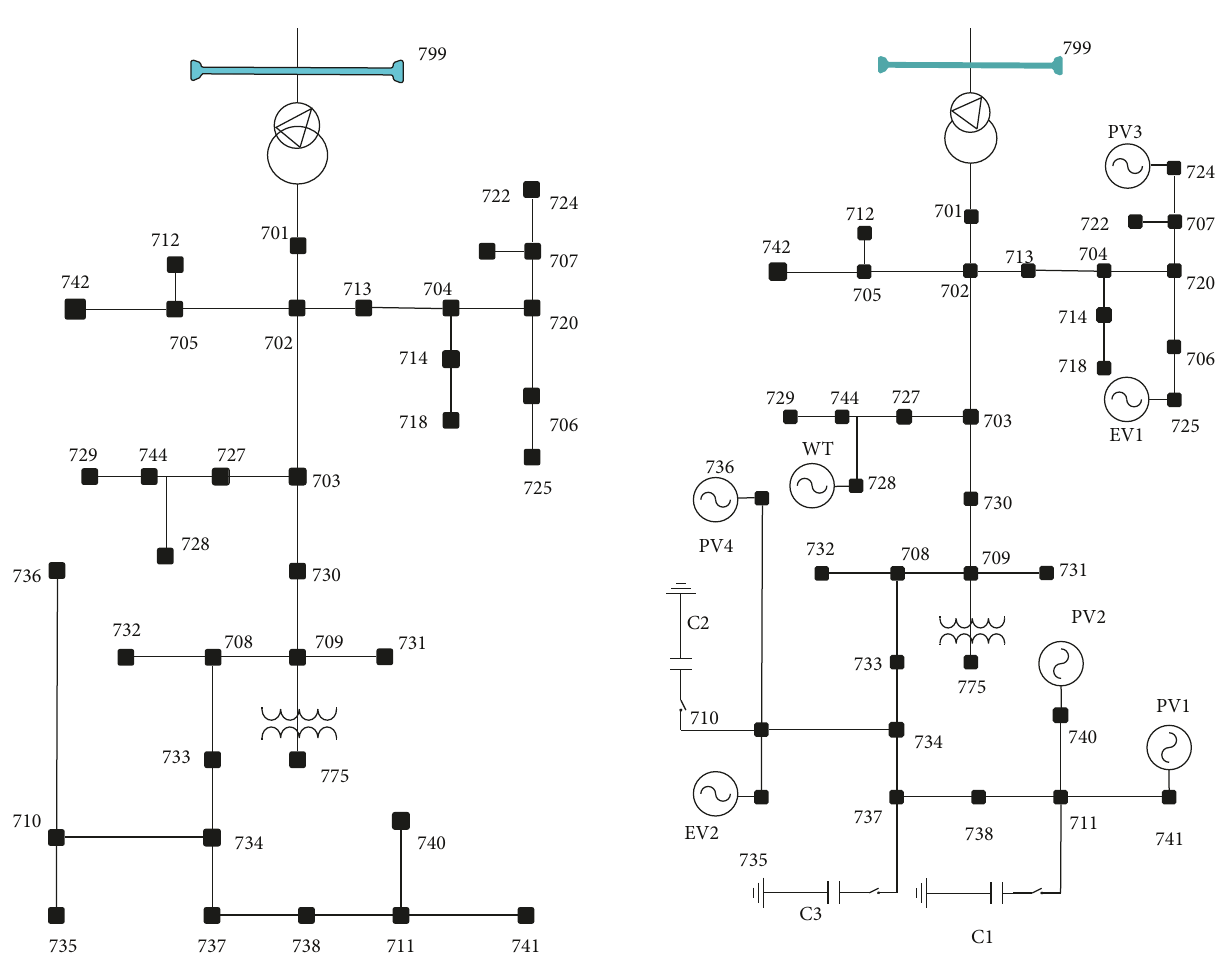
Figure 5: Original topology of the IEEE37 node power distribution